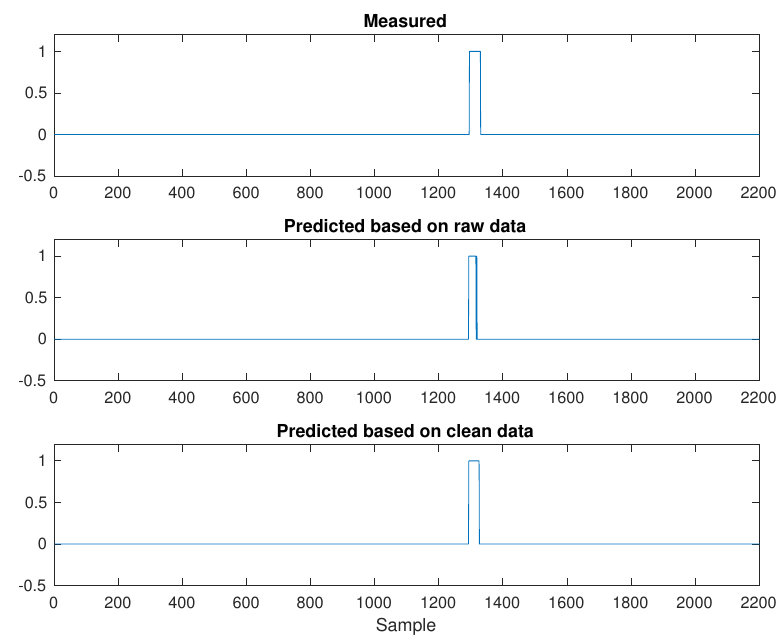
Figure 10. Flare 1: Partial least squares-discriminant analysis (PLS-DA) based on raw and clean data.